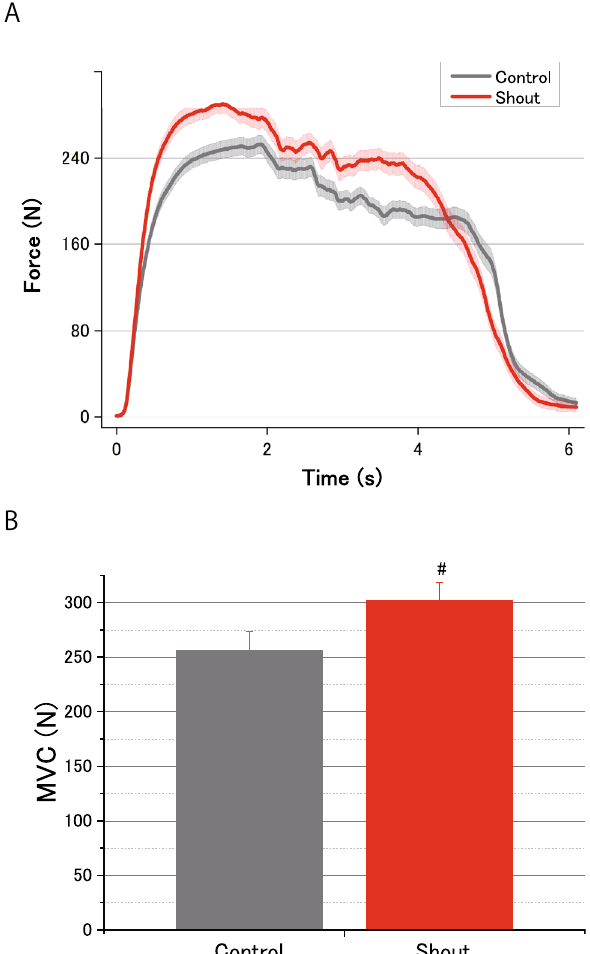
Figure 3. Effects of shouting on the maximal voluntary contraction force (MVC) of handgrip. (A) Typical recordings of handgrip force in each experimental condition (control or shout), which were averaged across all participants. (B) The averaged MVC across the five handgrip trials for the two conditions. The shout condition resulted in a greater handgrip MVC compared with the control condition. Data are expressed as the mean ± standard error of the mean ( # P < 0.01, paired t